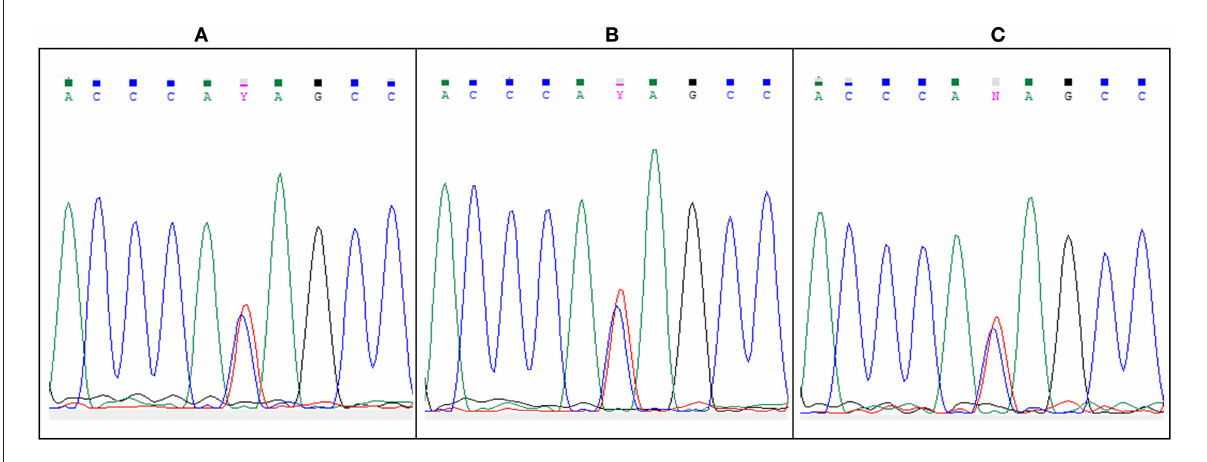
FIGURE3 Heterozygous C > T BLNK mutation revealed by Sanger sequencing of BLNK in (A) whole blood at diagnosis, and in (B) T-cells and (C) non–T-cell PBMCs at remission.